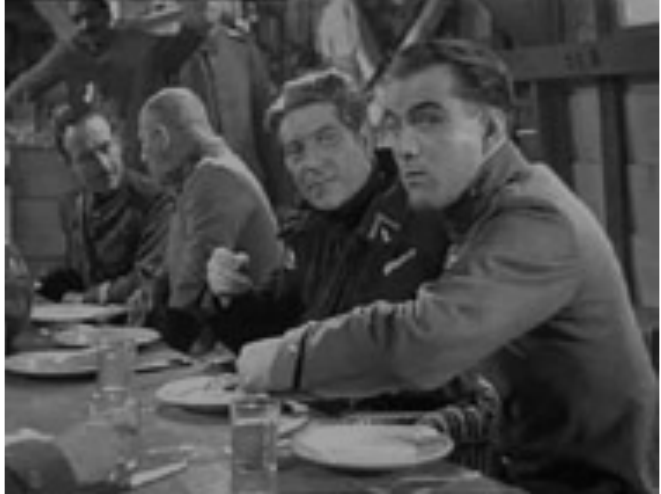
Figure 1 Le Grande Illusion . Director: Jean